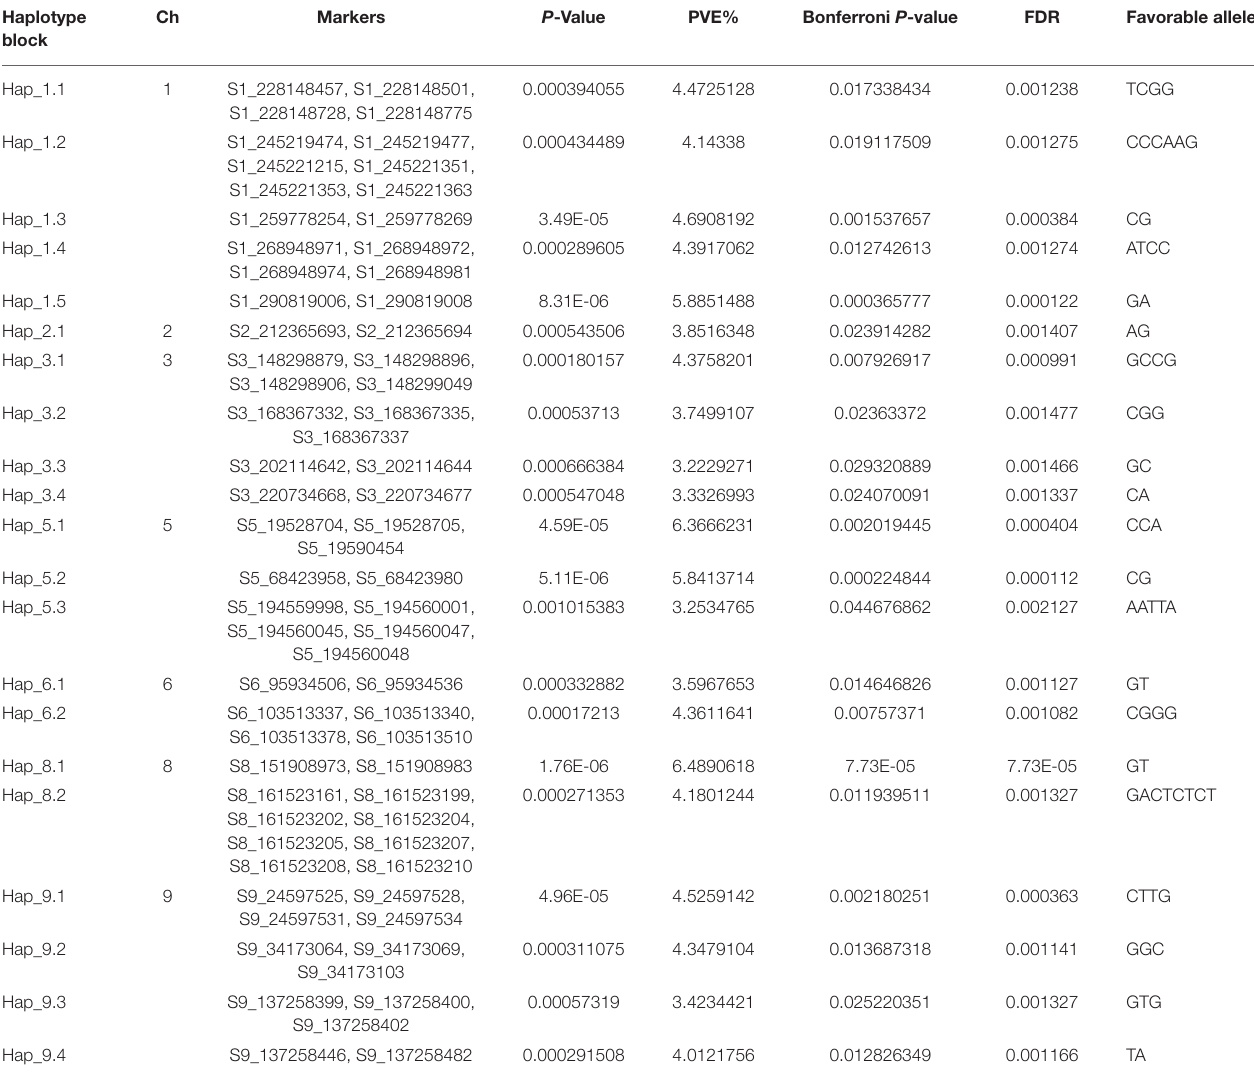
TABLE 3 | Significant haplotypes identified in the CAAM panel for resistance to charcoal rot using haplotype regression. Haplotype Ch Markers P -Value PVE% Bonferroni P -value FDR Favorable block